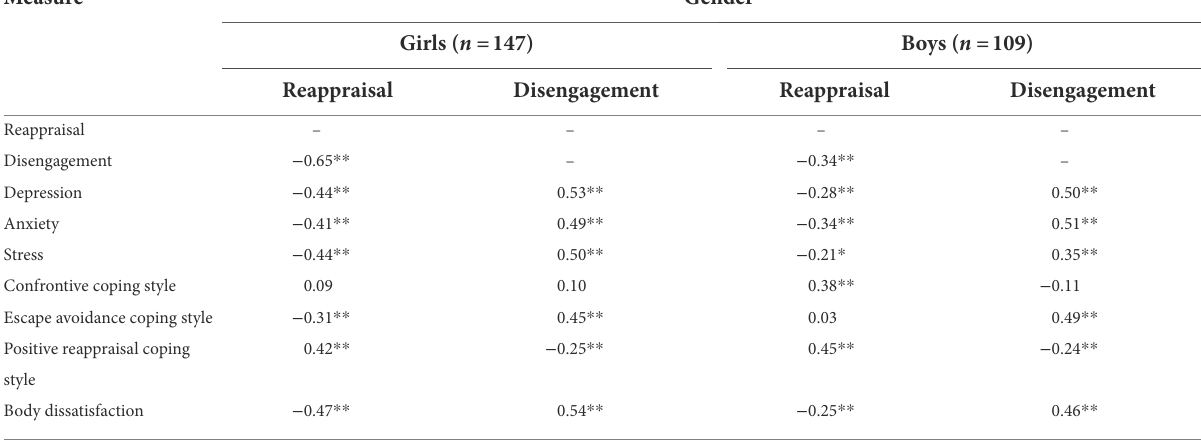
Table 5 Pearson correlation coefficients between bcri subscales scores and other study variables for subsamples of girls and boys.